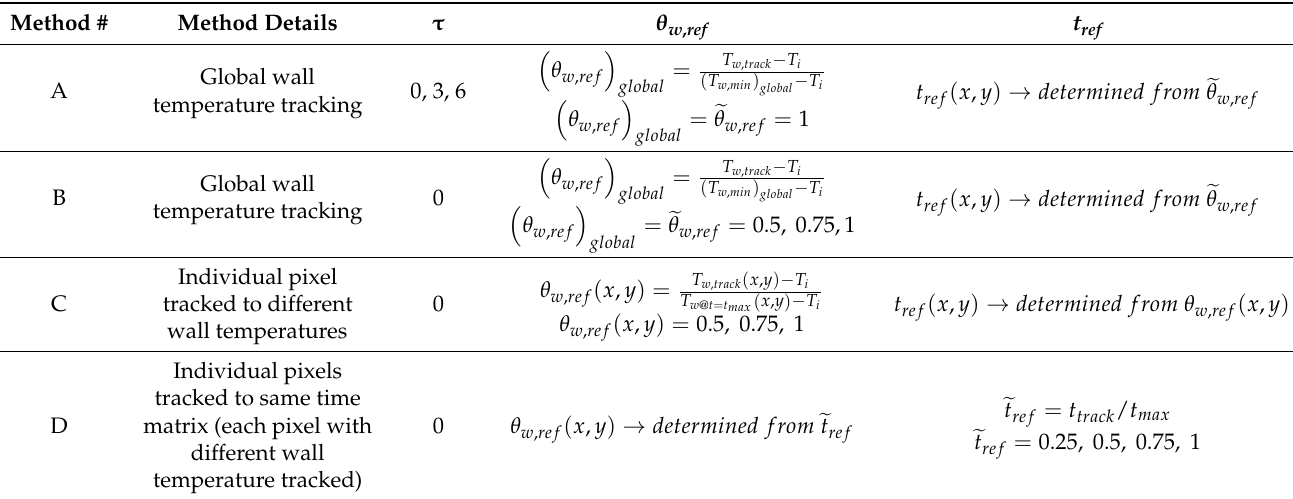
Table 1. Details of data reduction procedures.